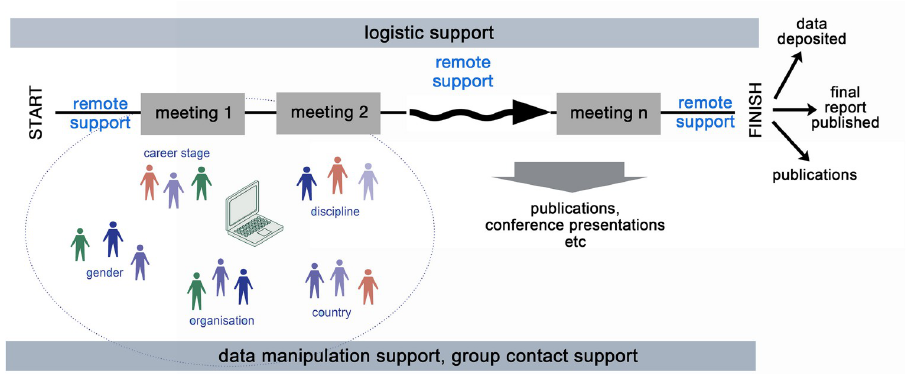
Fig 2. Working group workflow. A depiction of the way the working groups work together in our scenarios, where groups of diverse people meet together intermittently over a period of time in a supported environment to examine difficult, multi-disciplinary, problems. The meetings might each last up to a week, and are often at six month to yearly intervals.